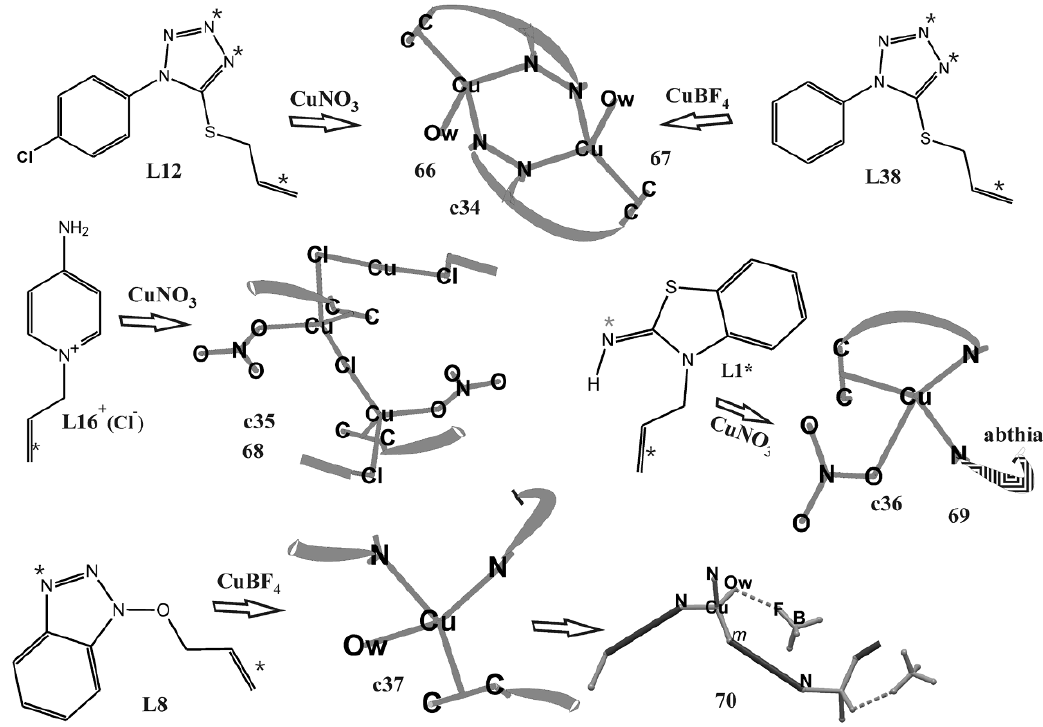
Figure 15. Structural genesis of C34-C37 fragments in 66-70